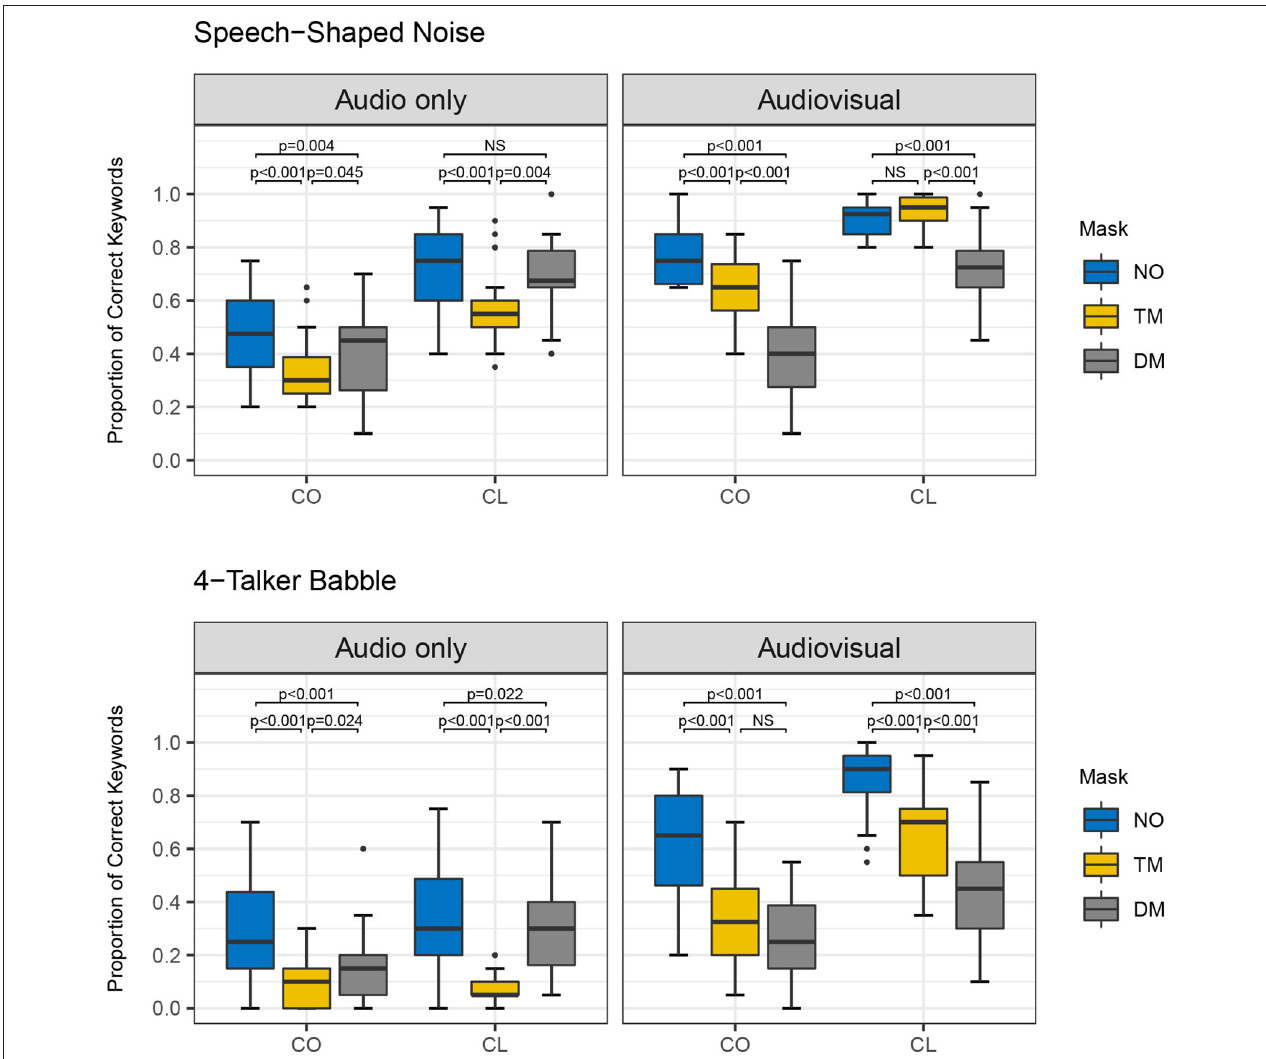
FIGURE 3 | Proportion of correct keywords in sentences for comparisons of no mask (NO), transparent mask (TM), and disposable face mask (DM) produced with conversational (CO) and clear speaking (CL) styles presented in Audio only and Audiovisual modes with Speech-Shaped Noise and 4-Talker